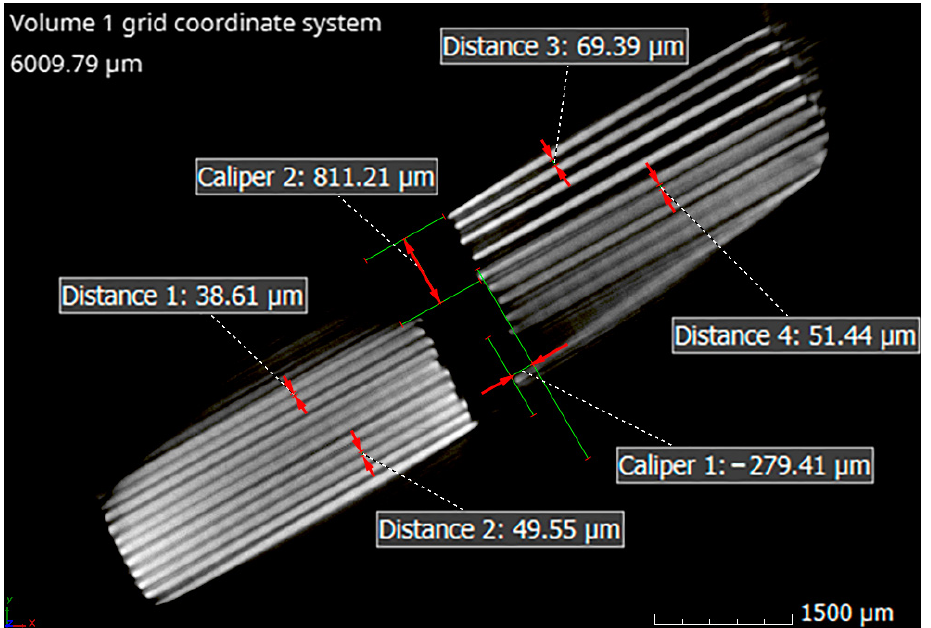
Figure 6. Layout of measurements on slices of tomograms. In view B, the lines show HTS tapes; the distances between them are increased for clarity.